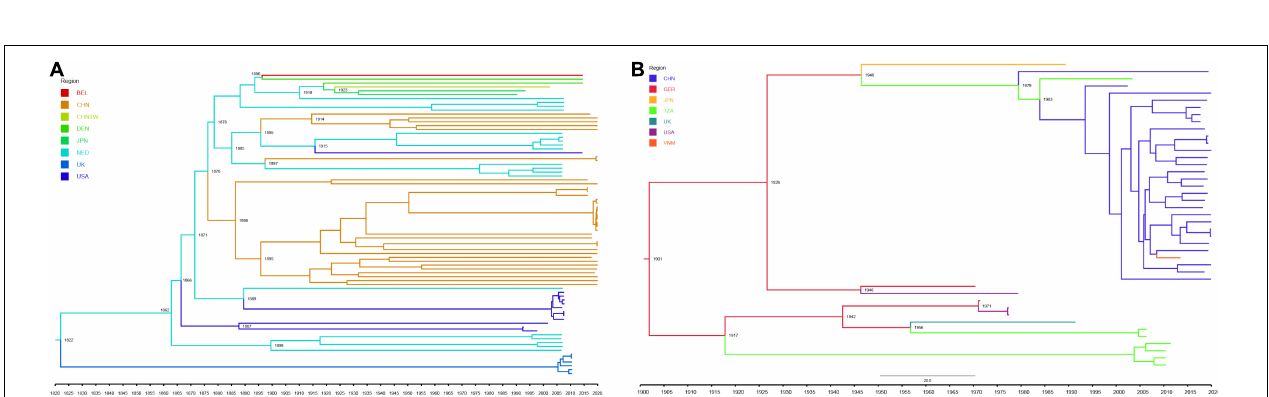
FIGURE 5 | Maximum clade credibility tree of FCoV-I (A) and CCoV-IIa (B) S1 gene. Viruses from different regions are denoted by different colors. Some important dates are marked on the branch nodes. (A) MCC tree of FCoV-I S1 gene was reconstructed by the strict clock model with the Bayesian Skygrid coalescent model and four independent chains with a chain length of 1 × 10 8 using BEAST (version 1.10.4). (B) MCC tree of CCoV-IIa S1 gene was reconstructed by one chain with a chain length of 5 × 10 7 for CCoV-IIa under the uncorrelated lognormal relaxed clock model with the Bayesian skyline coalescent model using BEAST (version 1.10.4).